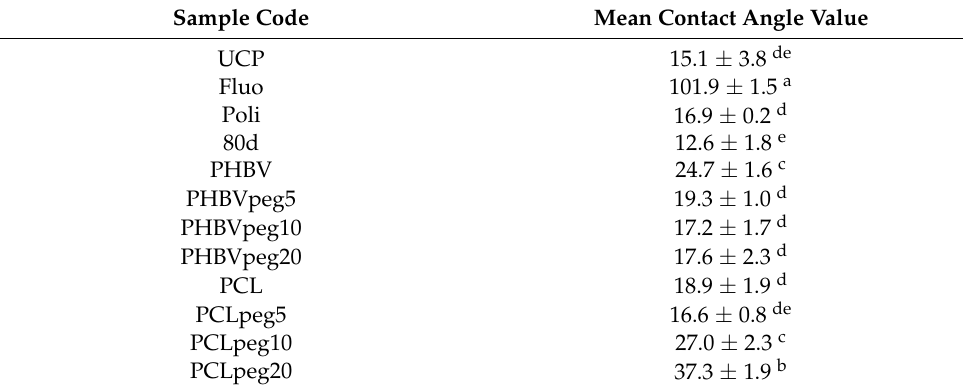
Different superscript letters indicate statistically significant differences ( p < 0.05). Table 5. Oil contact angle values of second set samples. Table 5. Oil contact angle values of second set samples.